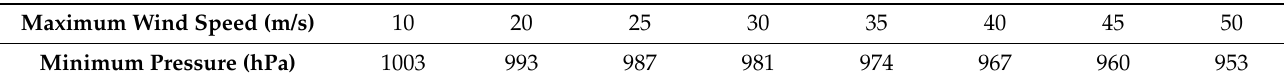
Table 3. Maximum wind speed and central pressure of the typhoons in the experiments of the maximum wind